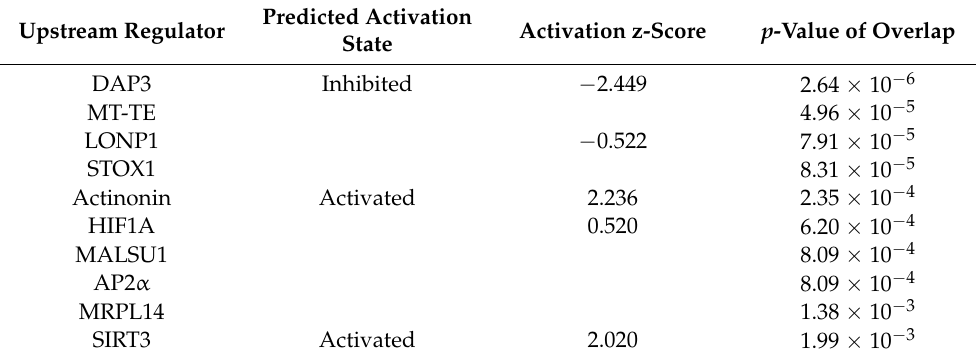
Table 1. Significant upstream regulators were identified following IPA upstream analysis of differen- tial gene expression in KGN granulosa cells treated with melatonin ( p < 0.05). Upstream